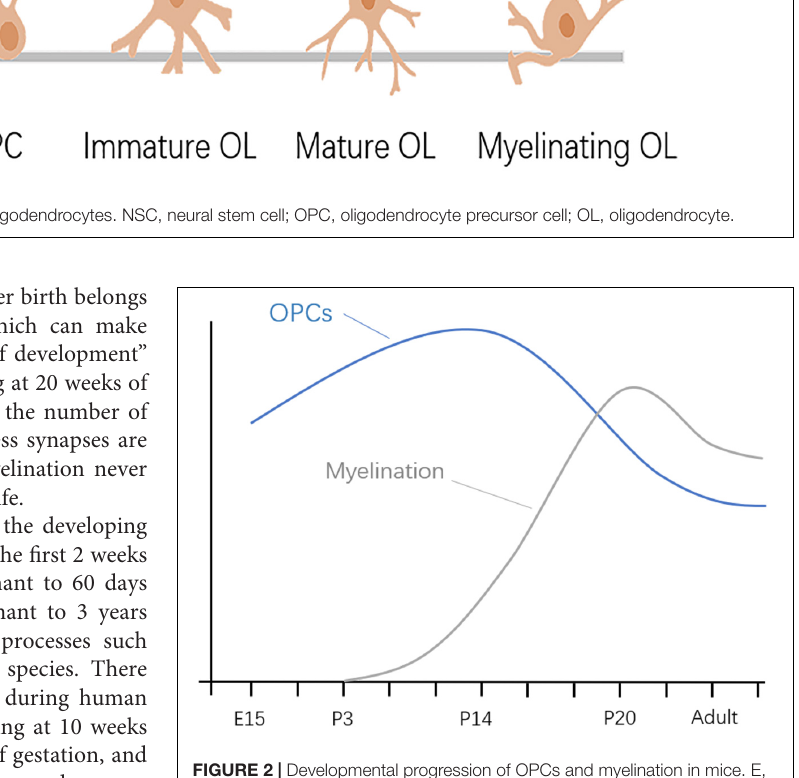
FIGURE 2 | Developmental progression of OPCs and myelination in mice. E, embryonic day; P, embryonic